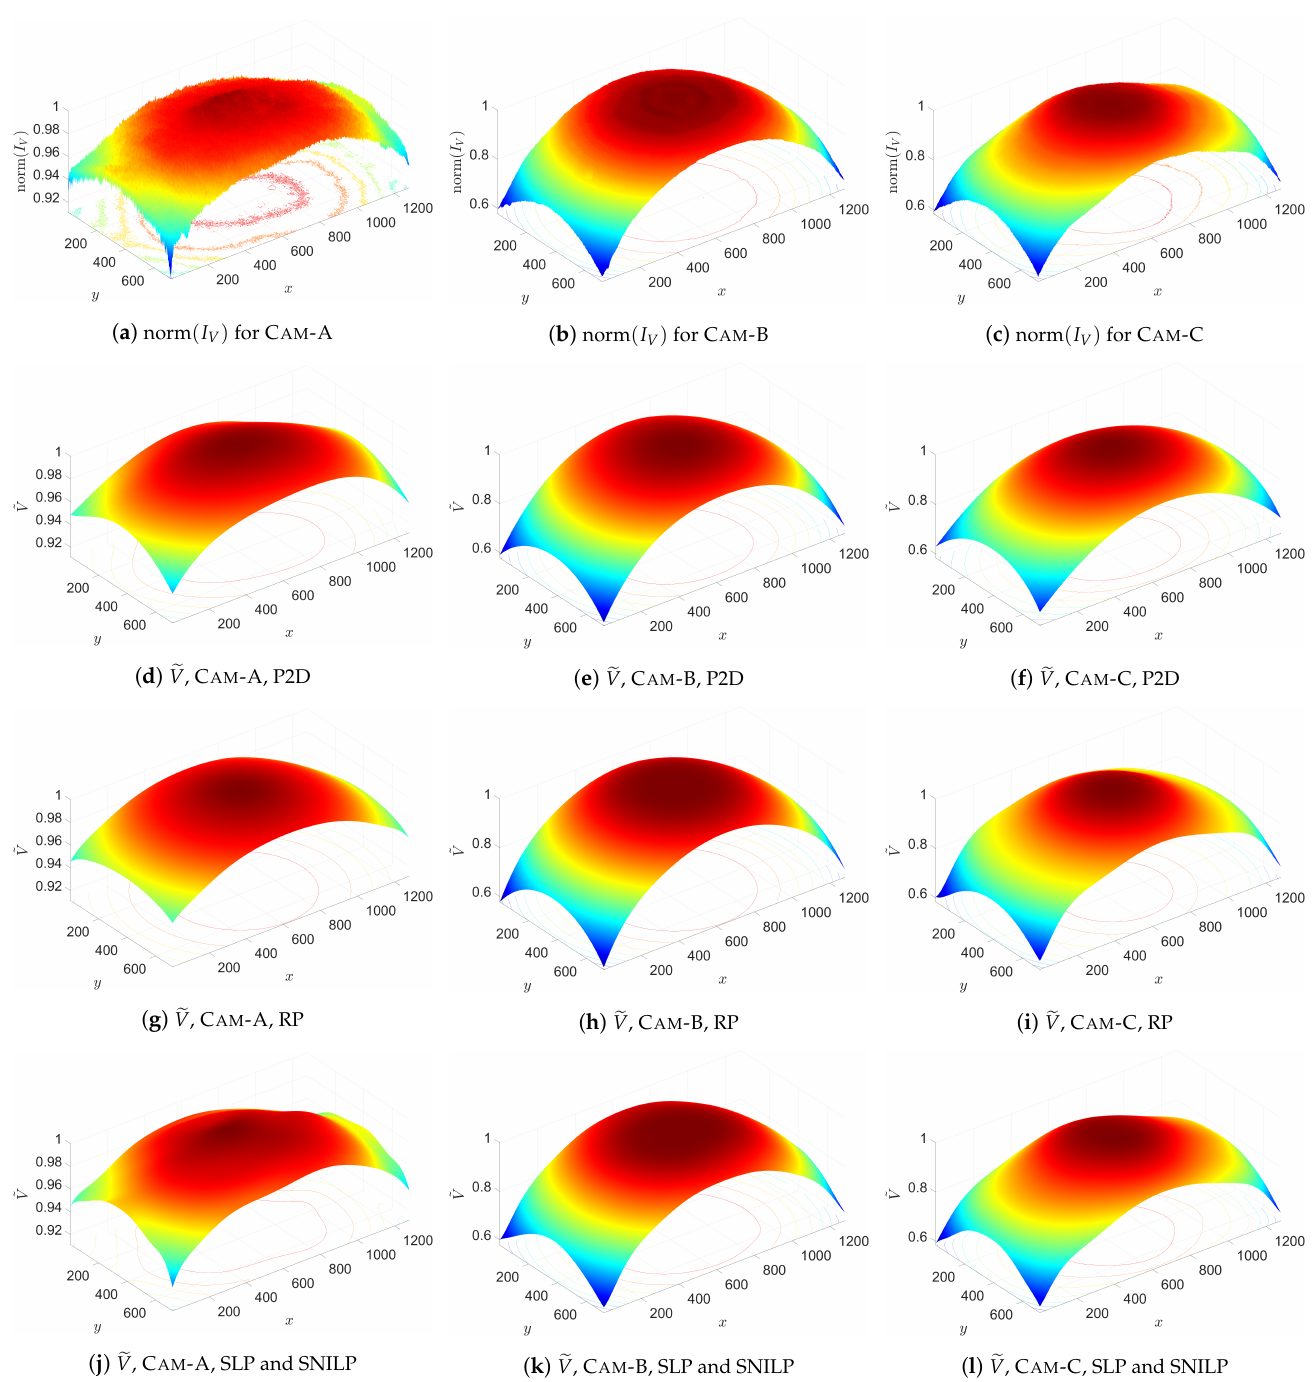
Figure 8. Comparison of vignetting estimates (cid:101) V obtained for the tested cameras and vignetting models for degree s = 10 of the used approximation polynomials. The charts ( j – l ) present results obtained for the SLP and SNILP models, which, in the case of the used parameter k = 25 (number of iterations), in the SPL model, are